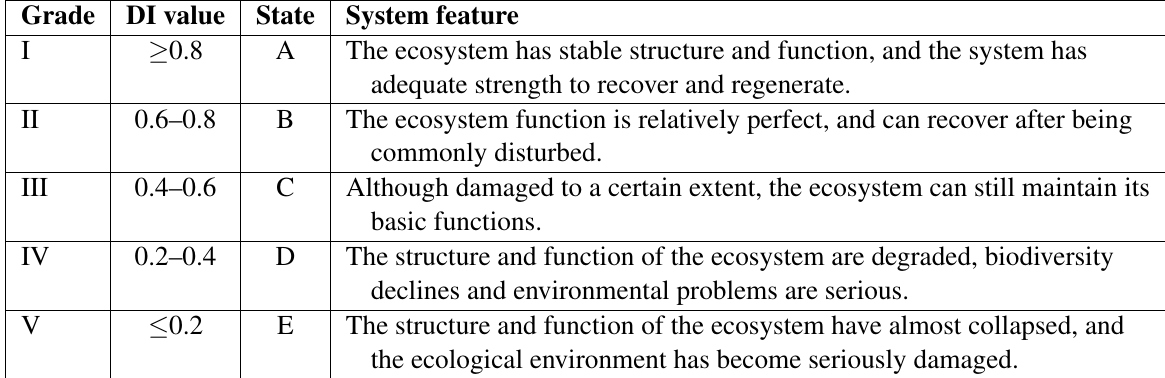
Table 5 Classification criteria and definitions of Futian mangrove wetland ecosystem evaluation.